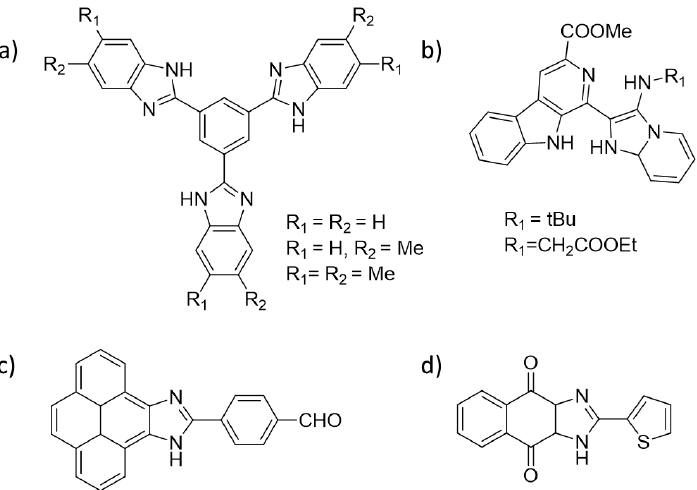
Figure 1. Examples of ( a ) tri-benzimidazoyl-, ( b ) β -carboline-imidazopyridine-, ( c ) pyrenoimidazolyl-, and ( d ) napthoimidazole dione- based molecular sensors used for fluoride detection.